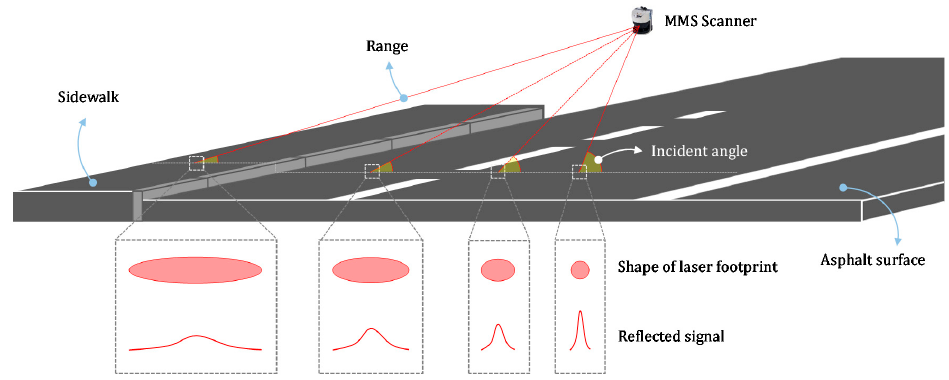
Figure 9. The effect of range and incidence angle on the shape of the laser footprint and the power of the reflected signal. As can be seen, as the range increase and the incidence angle decreases, area of the laser footprint increases, which degrades the quality of sampling.